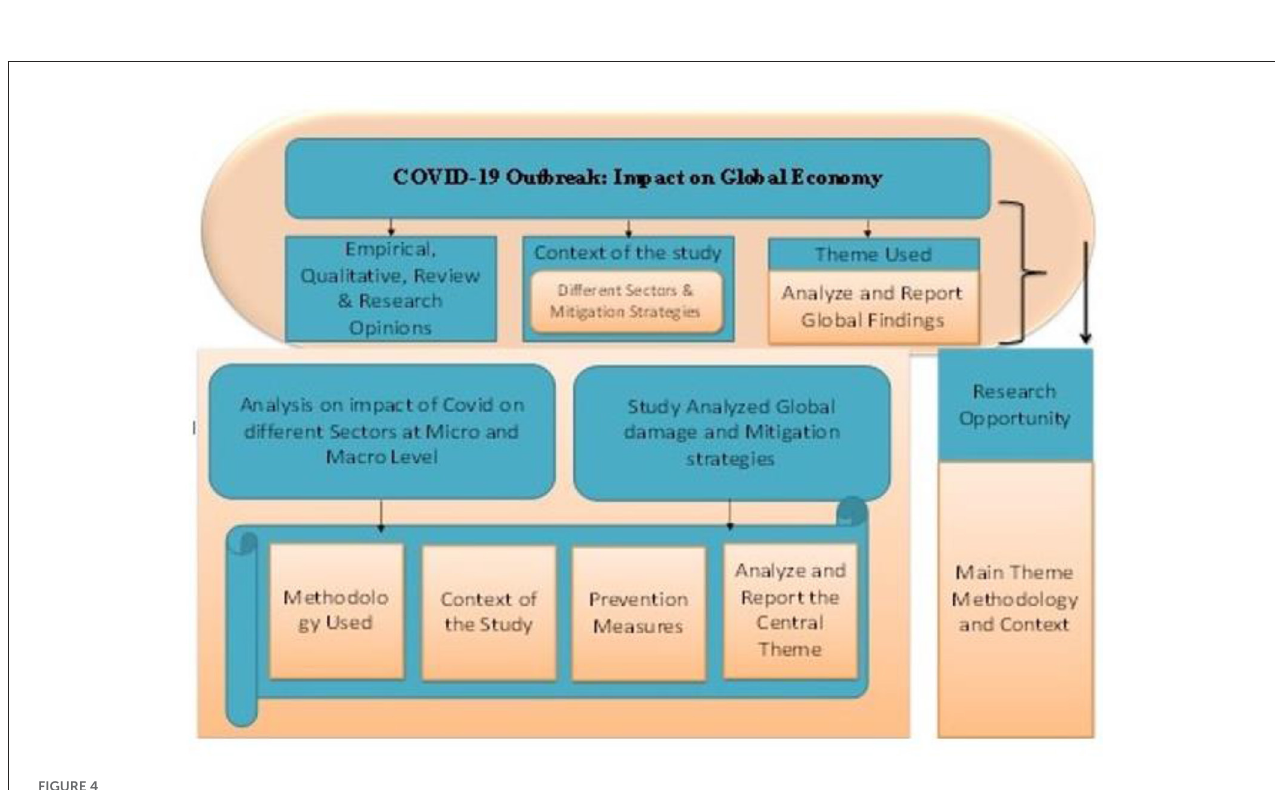
FIGURE4 Framework of the study. Source: Author’s constructed.